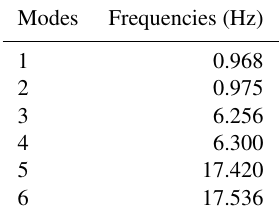
Table 2. First sixth-order natural frequencies of the